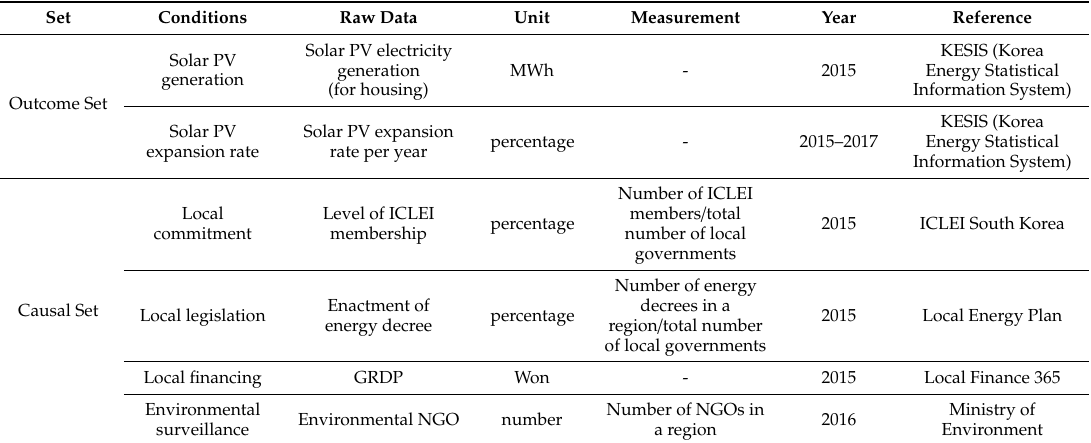
Table A1. Description of the outcome and causal set.